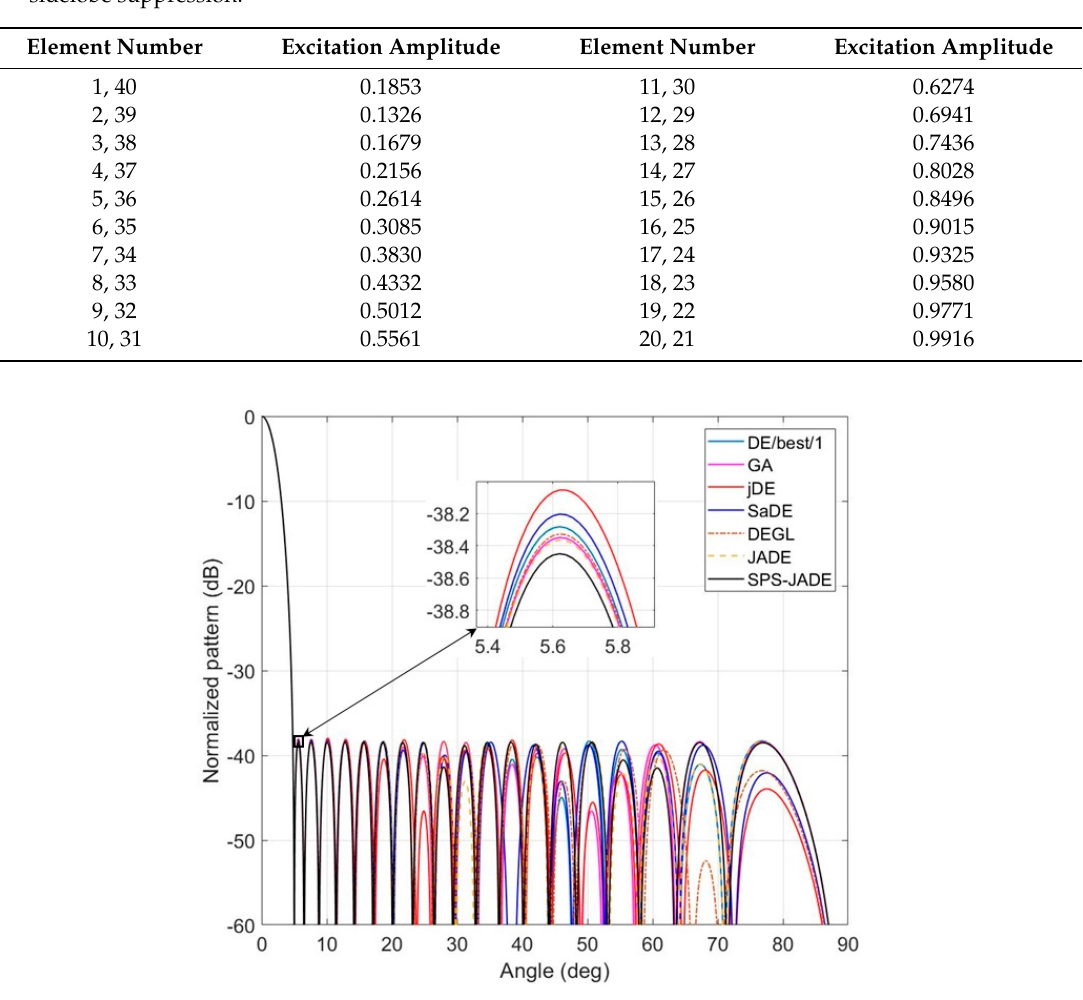
Table 2. The optimal excitation amplitudes of array elements computed by SPS-JADE algorithm with sidelobe suppression.